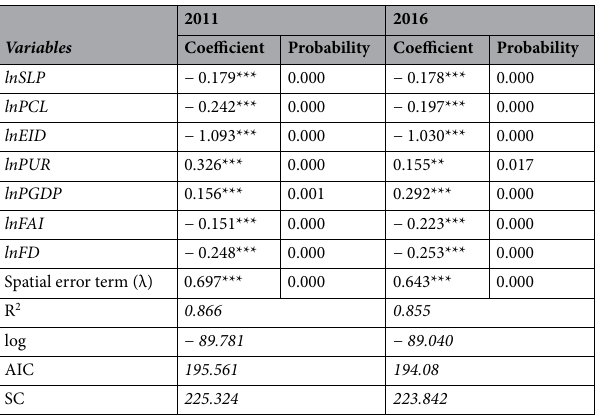
Table 4. Verification and parameter estimation results of SEM. *** p < 0.01, ** p < 0.05, *p < 0.1, t-statistics in parentheses. Italic values are the model goodness of fit, reflecting the basic information and model fit.